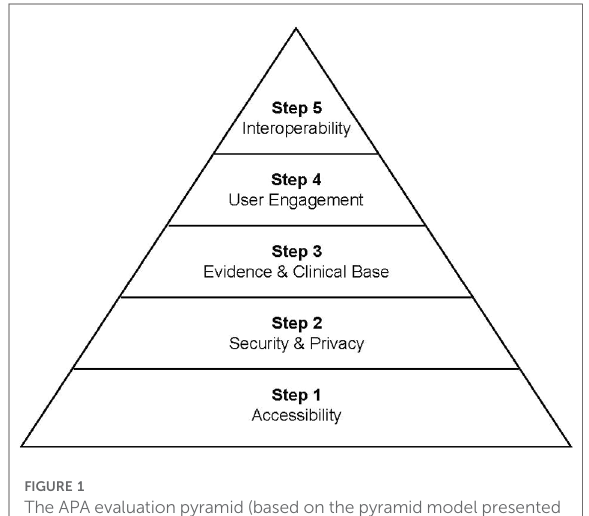
FIGURE 1 The APA evaluation pyramid (based on the pyramid model presented in Lagan et al, 2020)